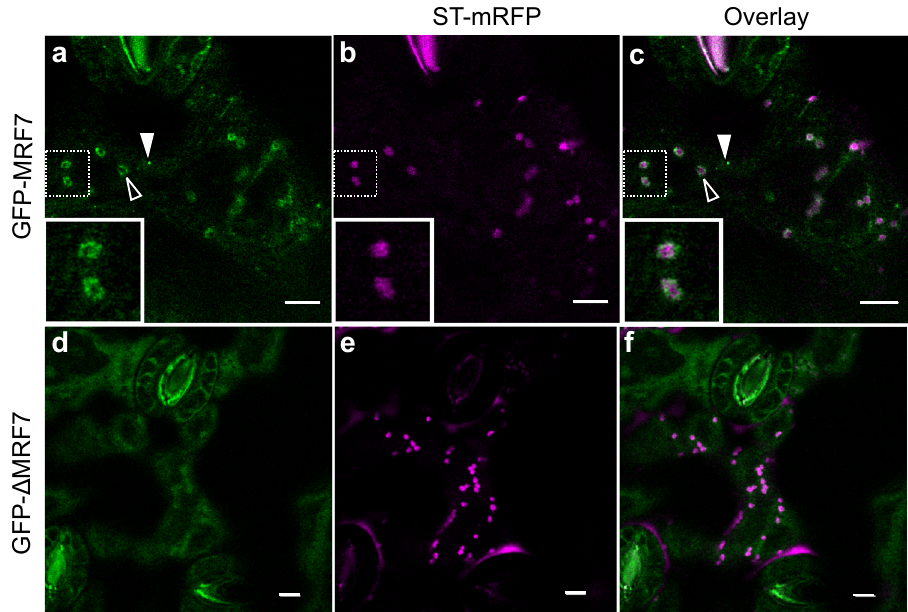
Fig. 4 Localisation of GFP-MRF7 and GFP- Δ MRF7 in A. thaliana is consistent with that observed in tobacco. A. thaliana lines stably over-expressing GFP- MRF7 (green) or GFP- Δ MRF7 (green) were generated by fl oral dipping of wild-type Col-0 plants. Stable lines from T4 generation were then crossed with a ST-mRFP (magenta) marker line. Progeny were imaged 14 days post-germination. a – c As in tobacco leaf epidermal cells (Fig. 2a – c), GFP-MRF7 localises both to puncta ( fi lled arrowheads) and to the Golgi surface (empty arrowheads) in Arabidopsis leaf epidermal cells. Magni fi cation in the top panel shows a detail of the Golgi localisation: GFP-MRF7 fl uorescence is brighter on subdomains of the Golgi. d – f As in tobacco leaf epidermal cell (Fig. 2d – f) GFP- Δ MRF7 localises to the Golgi and in the cytosol in Arabidopsis leaf epidermal cells. Scale bar = 5 µ